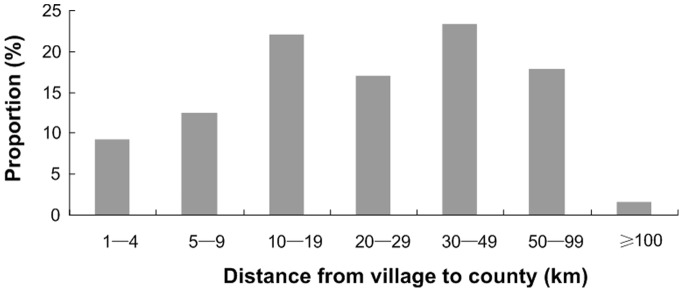
The distribution of distance from village to county.